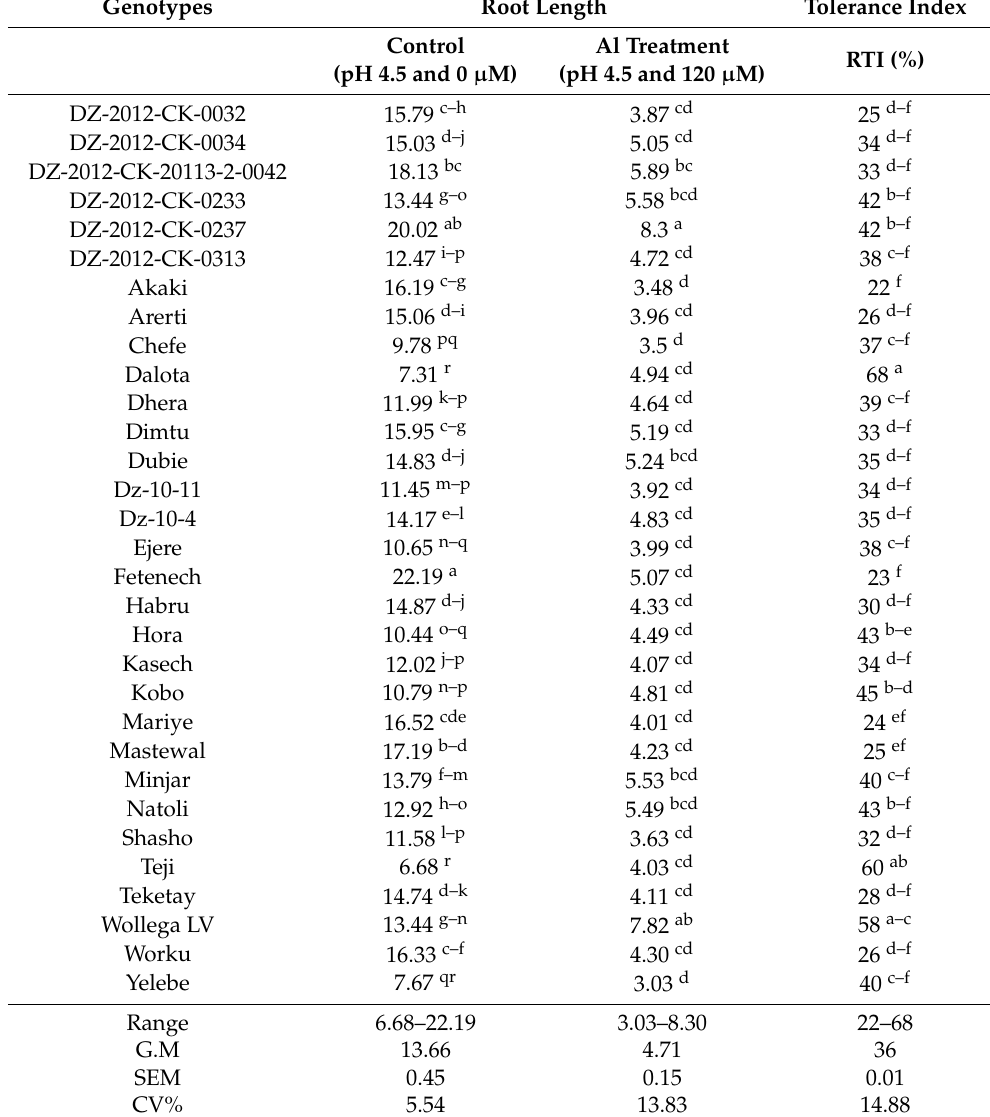
Table 5. Mean performances of chickpea genotypes at 0 and 120 µ M Al